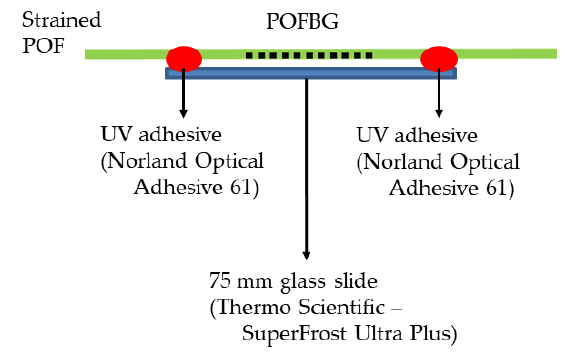
Figure 6. Strained POFBG sensor adhered to the glass slide.